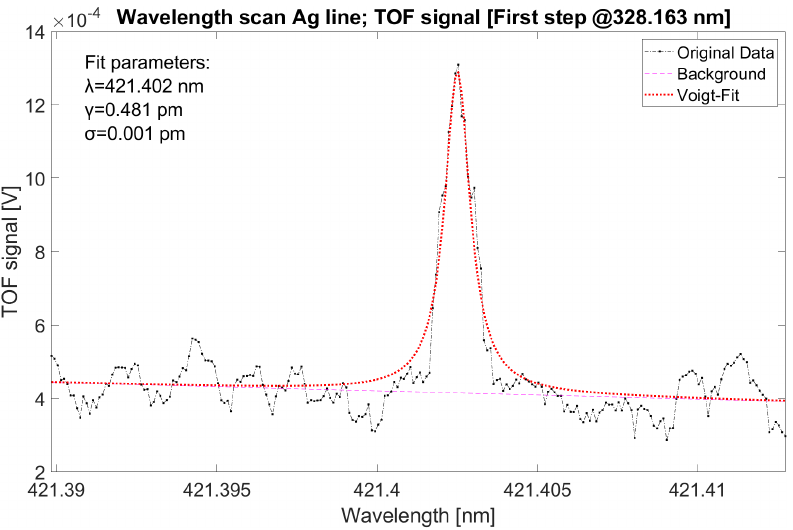
→ 4d 10 6d 2 D 3/2 Scanning range = 22 pm 3/2